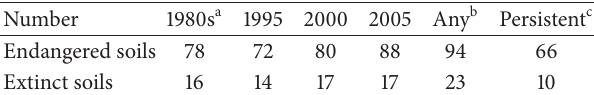
Table 5: Land use stress on soil over time.